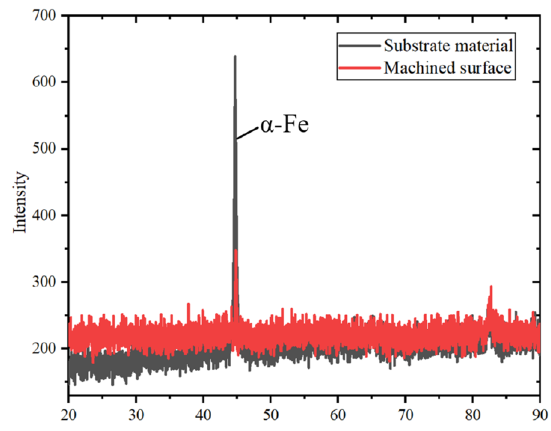
Figure 18 Comparative analysis of XRD diffraction results of machined surface and